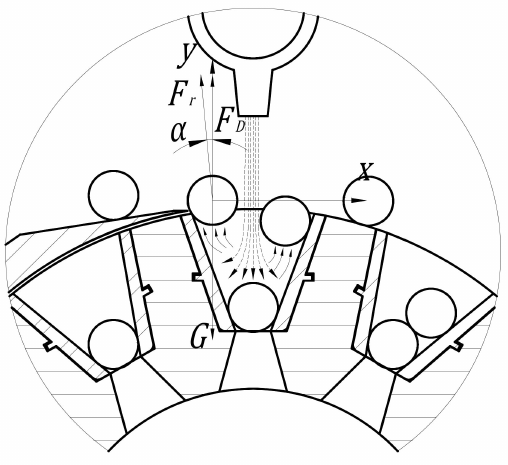
Figure 5. The force map of seeds cleaned out of filling